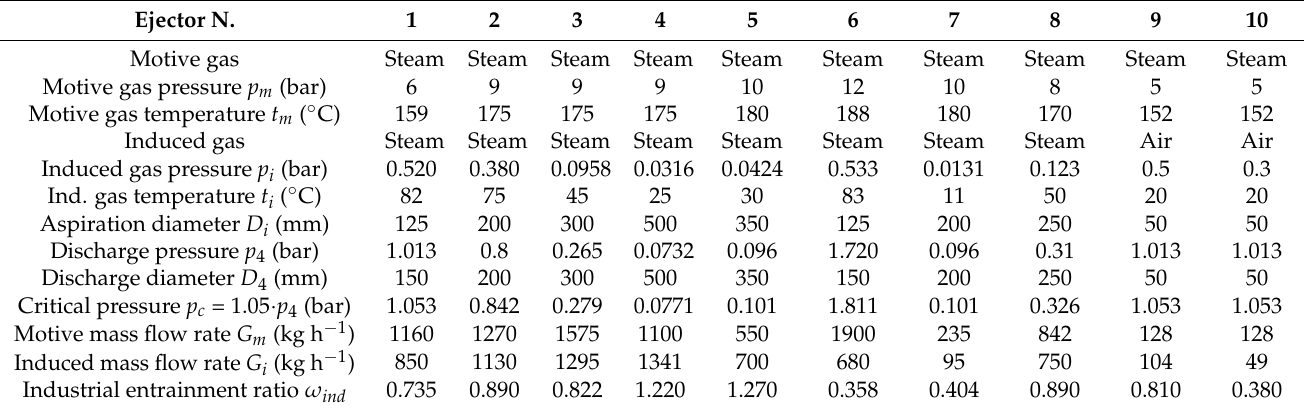
Table 1. Operating data of the high-performance industrial ejectors.